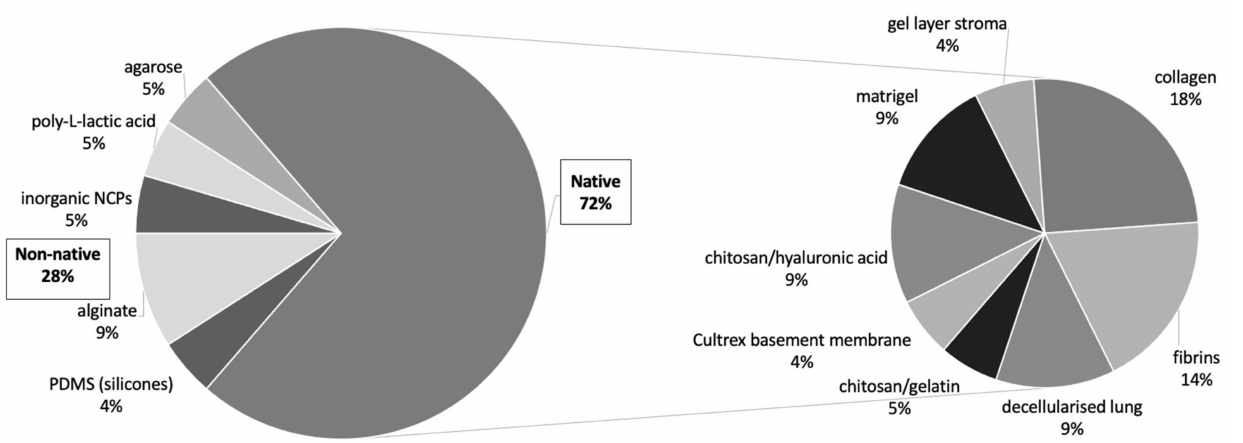
Figure 8. Drug resistance studies: scaffold types. Proportional representation of native and non-native scaffold types used in 3D in vitro tumour models in studies regarding drug resistance with preference towards native scaffold materials over non-native material